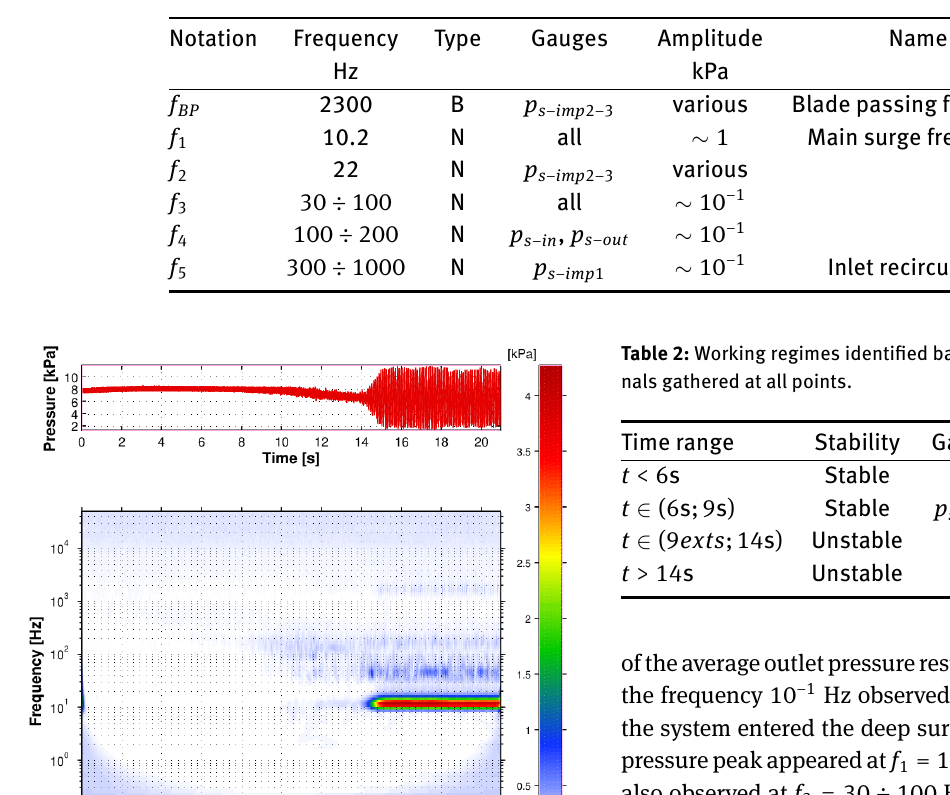
Table 1: Characteristic frequencies observed in the dynamic analysis; abbreviations: N-present at a unstable regime, B-present at all condi- tions.